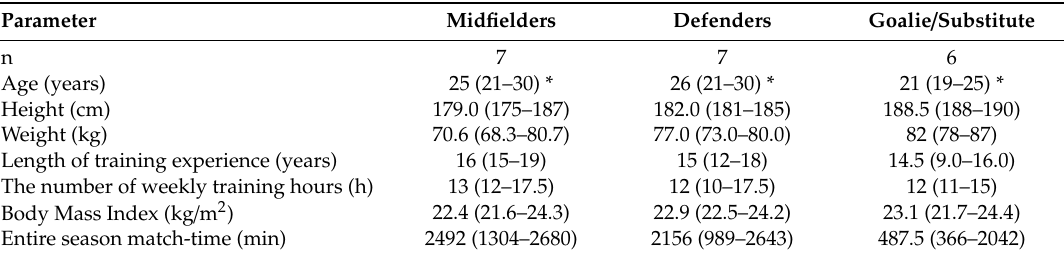
Table 2. Baseline characteristics of the